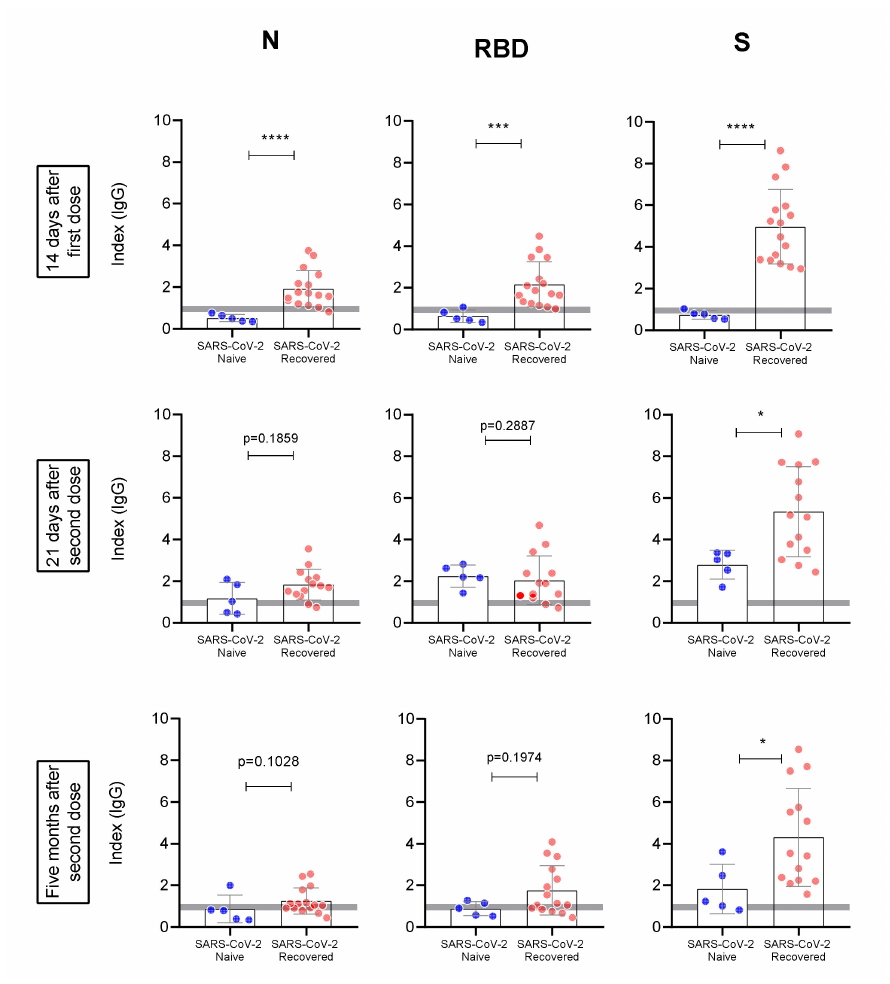
Figure 2. Evaluation of antibody response against N, RBD, and S between naïve (blue) and recovered (pink) individuals. The antibody response was evaluated in each timepoint after vaccination (T2, T3, and T4, respectively). Statistics were calculated using the unpaired Mann–Whitney test. Horizontal gray bars in A and B represent the cutoff and indetermined zone of the ELISA tests. * p < 0.05, *** p < 0.001, **** p <